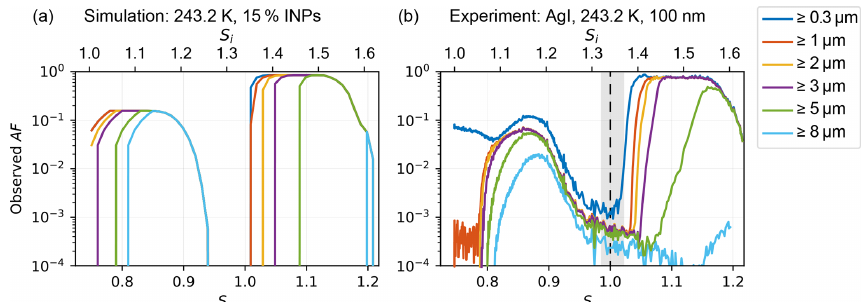
Figure 10. (a) Simulated activated fraction curve as a function of S w with a prescribed fraction of INPs of 15% for S w < 1 and (b) measured activated fraction of d m = 100nm silver iodide (AgI) particles, both at T = 243K, with a particle residence time of τ = 13 . 7s at p = 965hPa. Sizes stated in the legend indicate what fractions of all particles entering the chamber are activated and grow to or beyond the indicated size. Grey shading refers to chamber uncertainty around S w = 1 . 0 (see Sect. 3.1 for details).